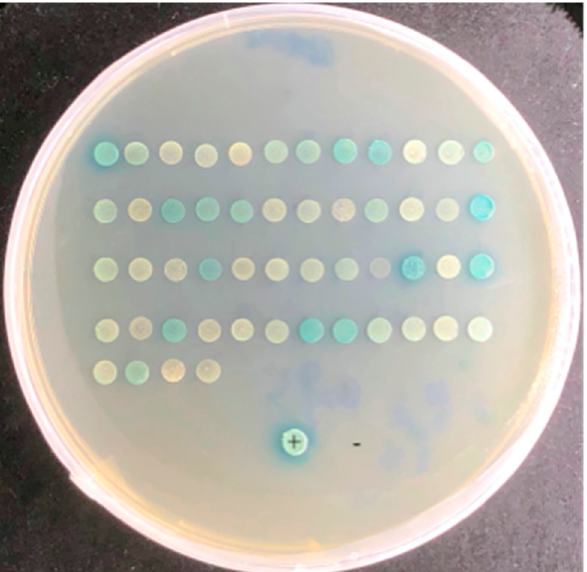
Figure 1. Positive clones of the pGBKT7–ApCE22 interaction gene on a double-screen plate. Note: +: stands for positive control. − : stands for negative control. The first screening step is to screen for interacting prey proteins from a yeast library of hybrid bamboo using effector ApCE22 as a bait protein, and the direct screening marker for this step is colony bluing. The second screening step is to pick out the blue colonies obtained in the first step individually and screen them again.